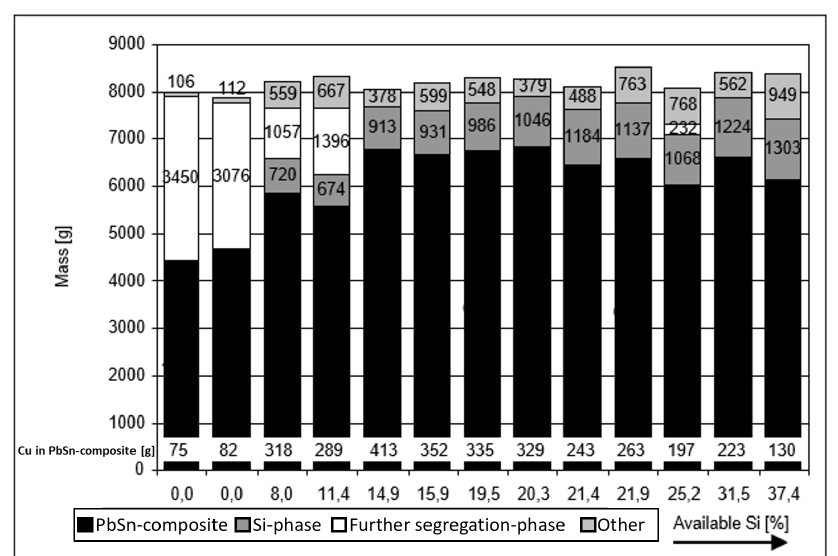
Figure 7. Quantity distribution for the products depending on the “available” silicon (cooling rate ∼ 5 ◦ C/min, temperature segregation 650 ◦